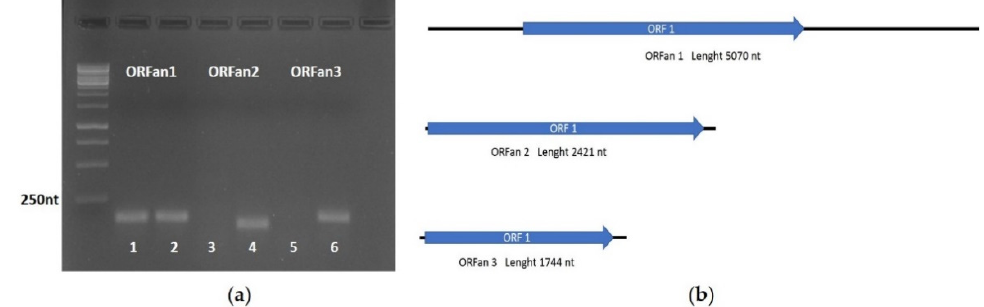
Figure 5. ( a ) Electrophoresis gel of the real-time PCR amplification products from ORFan1, ORFan2, and ORFan3 cDNAs. To confirm the RNA nature of the contigs, real-time PCR reaction was performed on cDNA samples and total nucleic acid samples from Candida stellata strain DBVPG 6714 and Starmerella bacillaris Cz12. 1: Total nucleic acid of Candida stellata DBVPG 6714; 2: cDNA of Candida stellata DBVPG 6714; 3 and 5: Total Nucleic of Starmerella bacillaris Cz12; 4 and 6: cDNA of Starmerella bacillaris Cz12; ( b ) Genome organization of the three ORFan contigs considered in our study. A black line represents the contig, while a blue arrow represents the open reading frame (ORF).